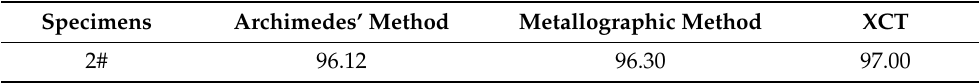
Figure 13. Metallographic cross-sectional examination of sample 2: ( a ) plane obtained from XCT analysis; ( b ) image captured via OM-after binarization process. Table 6. Microscopic density measurements